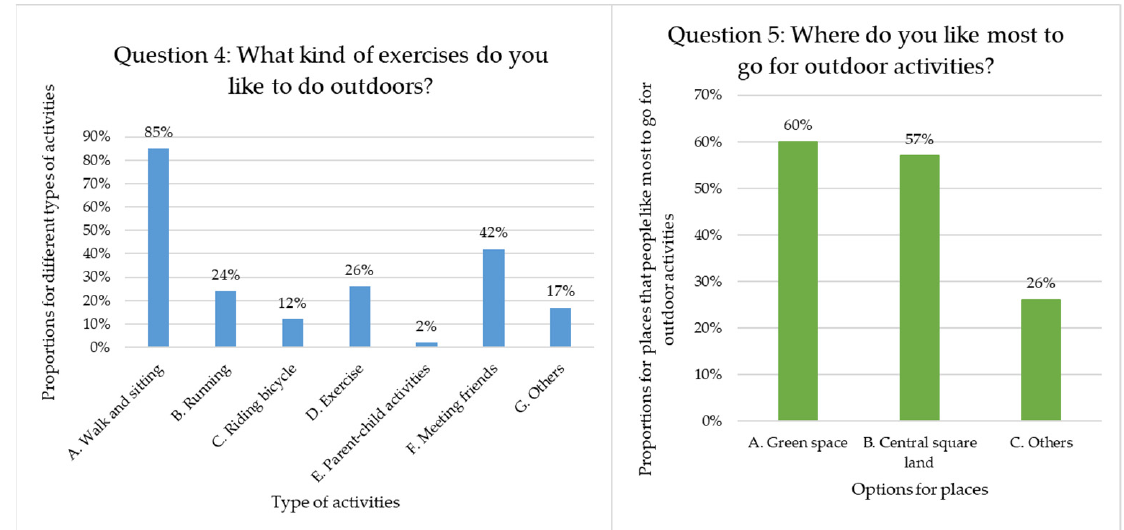
Figure 8. The survey results for Questions 4 and 5 of the questionnaires.